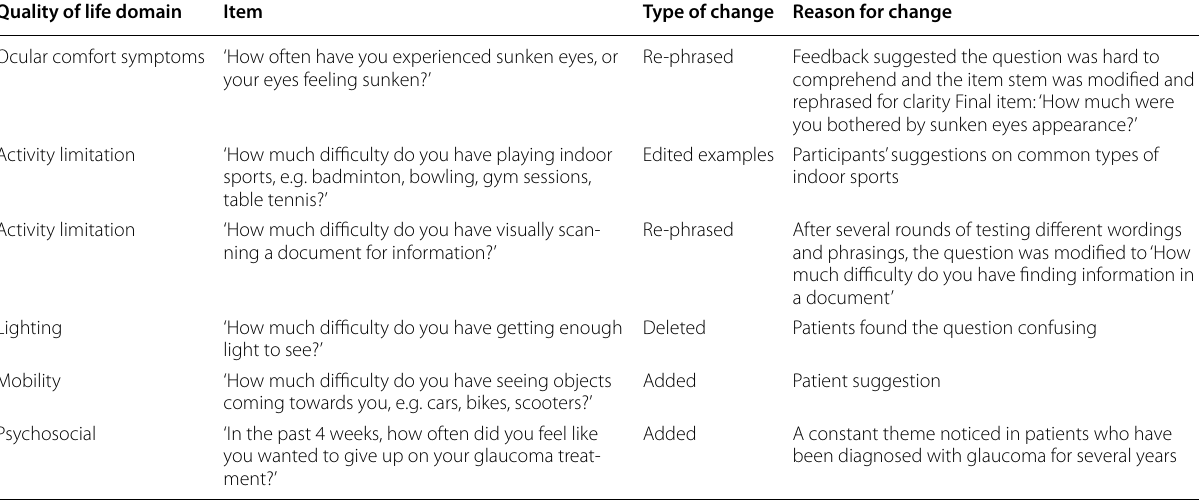
Table 5 Examples of item modifications following the cognitive interview process Quality of life